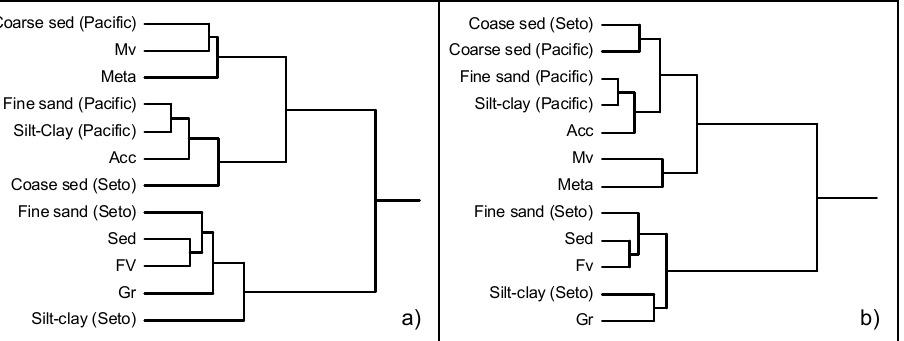
Figure 7. ( a ) Cluster dendrogram obtained using a dataset of 39 elements (excepting CaO, Sr, and heavy metals); ( b ) Cluster dendrogram obtained using a dataset of 21 elements (immobile elements). Sed: sediments and sedimentary rocks; Acc: sedimentary rocks of accretionary complexes; Mv: mafic volcanic rocks; Fv: felsic volcanic rocks; Gr: granitic rocks; Meta: metamorphic rocks.